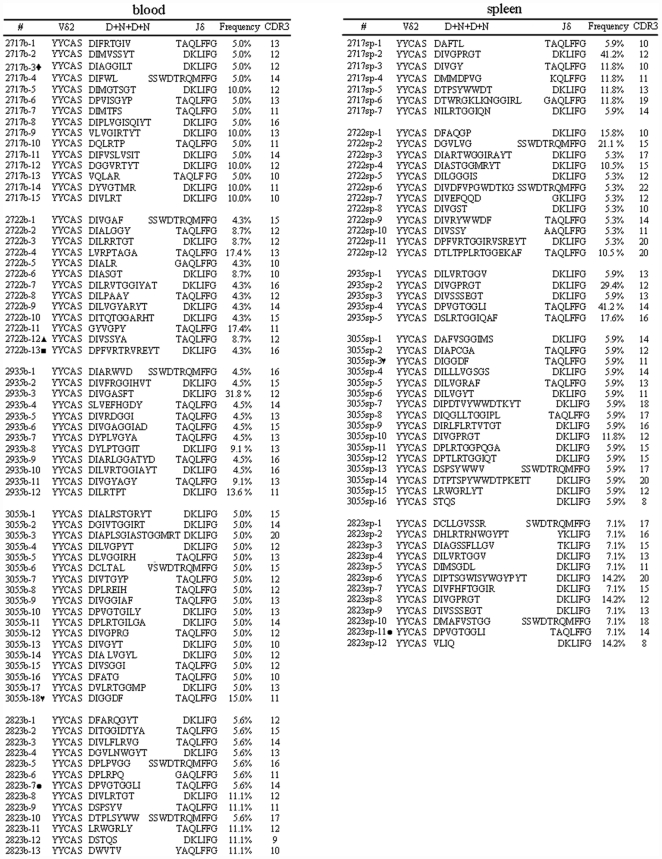
Broad T cell repertoire in Vγ2Vδ2 T-cell subpopulation in lymphoid system during primary Mtb infection of macaques.Shown are individual Vδ2 TCR clones isolated from PBL (left) and lymphocytes of spleen tissues (right) from 5 Mtb-infected macaques. The flow cytometry data indicating cellular expansion of Vγ2Vδ2 T cells in spleen were described in the text. Note that spleen lymphocytes in which major expansion of Vγ2Vδ2 T cells was seen were used for RNA isolation, cDNA synthesis and Vδ2 TCR sequence analyses. Note polyclonal sequences of Vδ2 TCR in cDNA derived from spleen lymphocytes and PBLs. Frequencies were expressed as the number of individual clones among the total analyzed clones. Similar data indicating polyclonal representation of Vγ2Vδ2 T cells in PBL before Mtb infection were also seen (data not shown). CDR3 were presumably indicated based on the definition for TCR β CDR3 [9]. D indicates diversity region; N indicates non-determining region of TCR receptor genes. Clones marked by ‘♦’ were present in the blood, lung and kidney (2717). Clones marked by ‘’ and ‘•’ were present in the blood, lung and spleen(3055 and 2823). Clones marked by ‘▴’ and ‘▪’ were present in the blood and lung(2722).